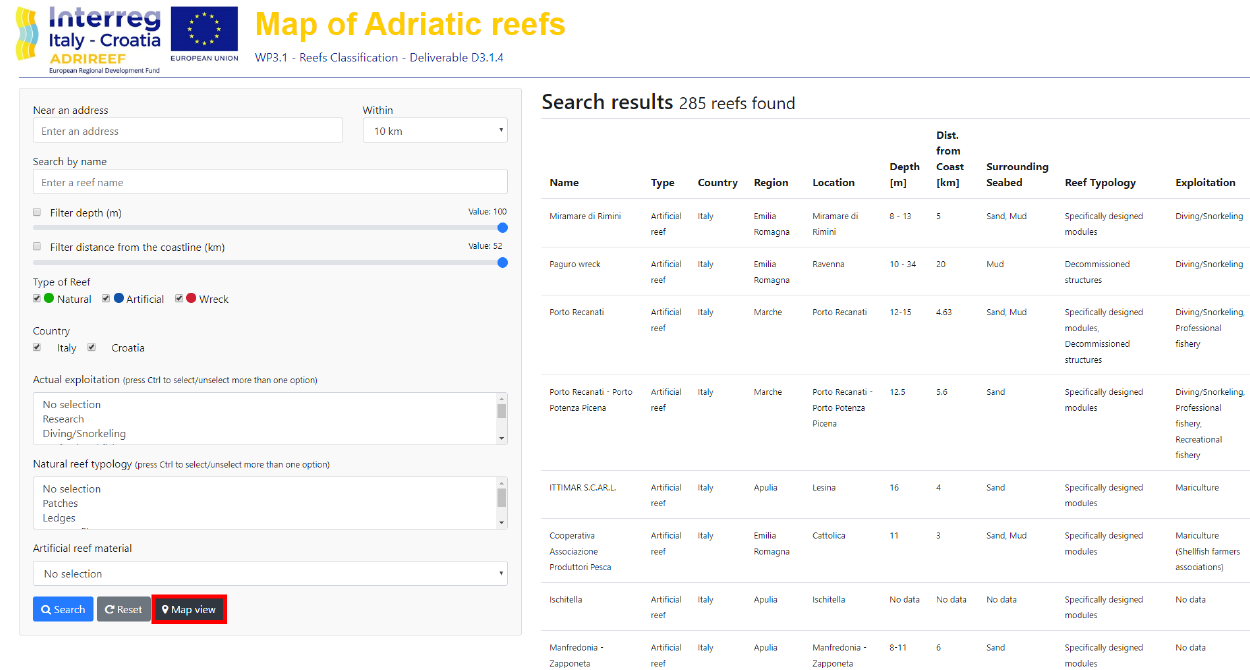
Figure 3. List view. Once elements are selected, it is possible to obtain some common information by clicking the “List view” button (that turns into “Map view” when the list is visualized, evidenced in red).